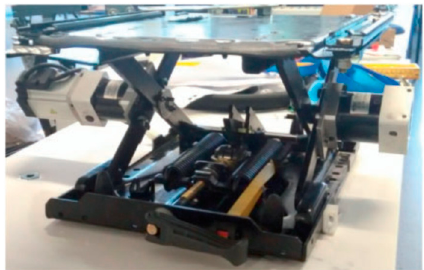
Figure 1. Active seating suspension system prototype [16].